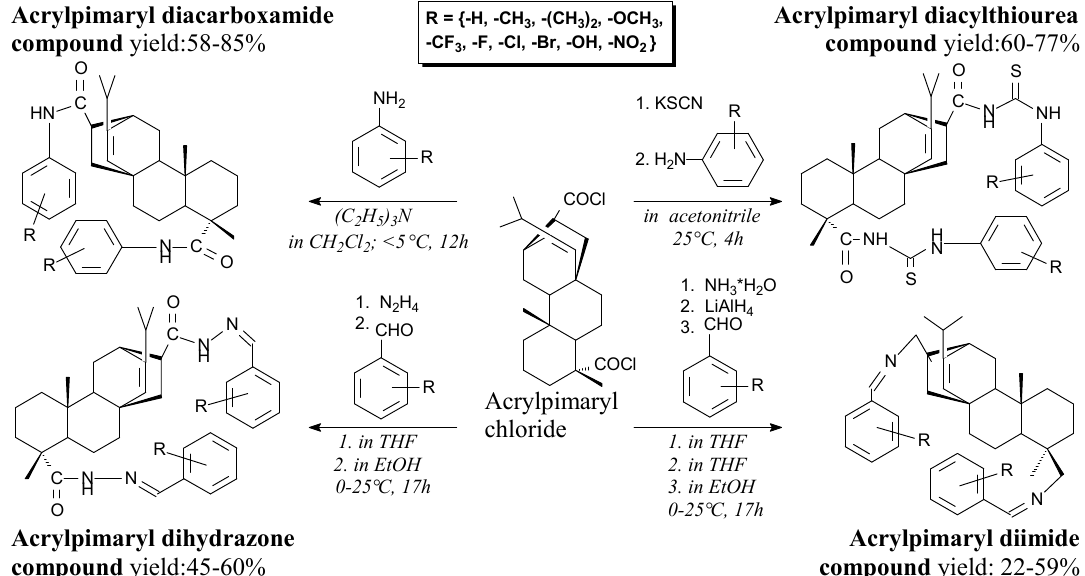
Scheme 40. Synthesis of rosin acid amides with thiadiazole groups.